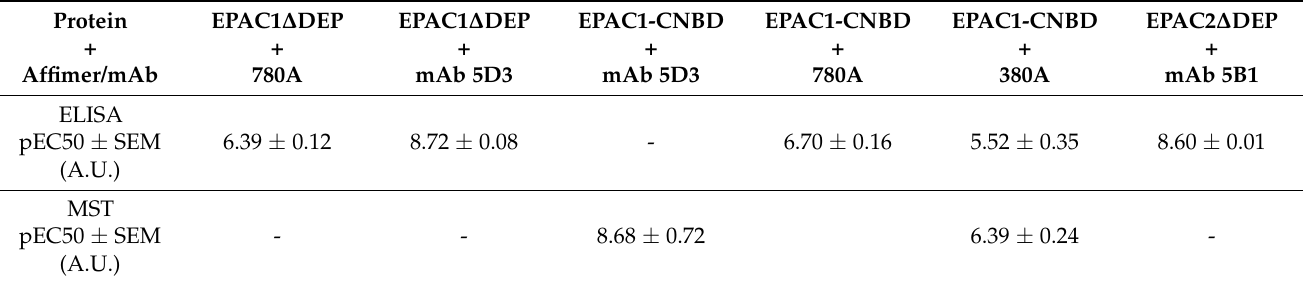
Table 2. pEC50 values from ELISA and MST binding assays. The pEC50 (negative log of the EC50) values of either Affimer (780A or 380A) or antibody (mAb 5D3 or mAb 5B1) when binding to different recombinant EPAC proteins were determined by ELISA or MST. The binding of Affimer to EPAC2 ∆ DEP and EPAC2-CNBD could not be determined because complete confidence interval could not be calculated for at least one parameter of the nonlinear regression curve fitting.